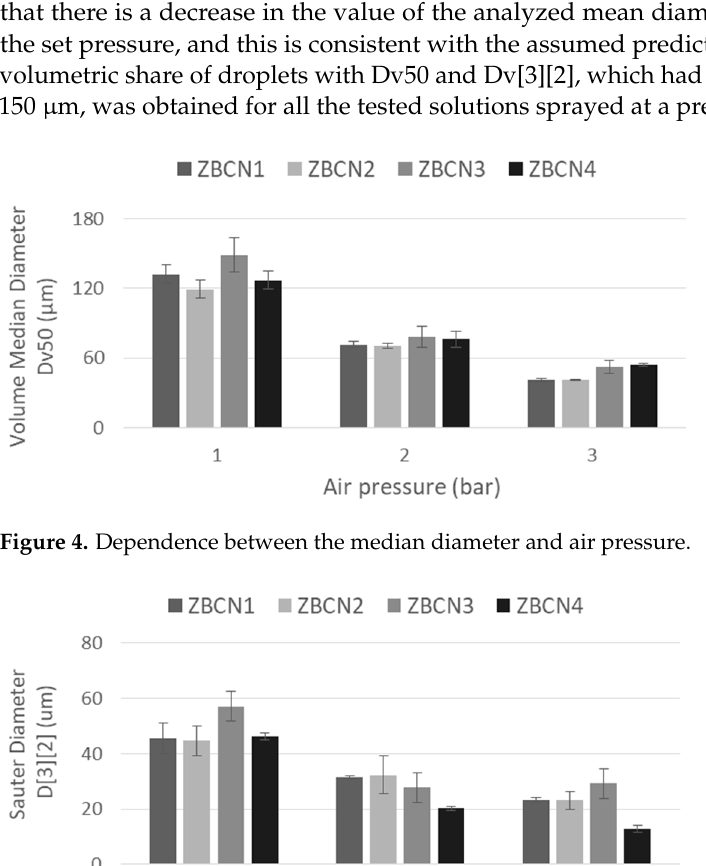
Figure 3. Distribution spectra of the droplet diameters obtained for: ( a ) ZBCN1 and a pressure of 1 bar, ( b ) ZBCN1 and a pressure of 3 bar, ( c ) ZBCN4 and a pressure of 1 bar, ( d ) ZBCN4 and a pres- sure of 3 bar. The red solid curve indicates the cumulative volume percentage per droplet size; the black dashed curve refers to the volume percentage per droplet size (volume frequency); and D and N are the parameters that describe the fitting of the obtained results to the log-normal size distri- bution.